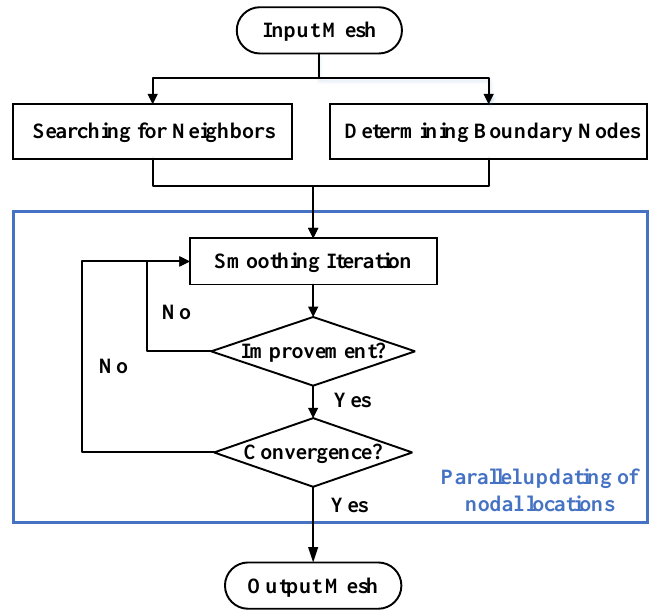
Figure 4. Workflow of the proposed parallel adaptive Laplacian mesh